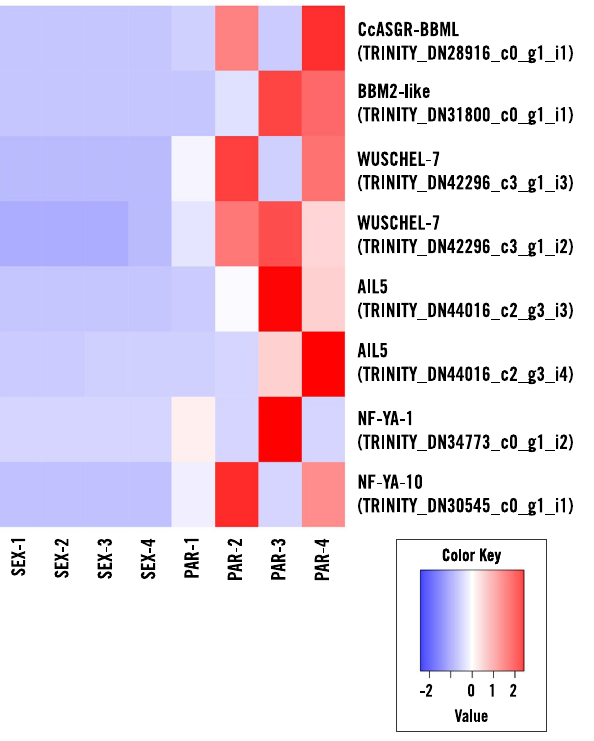
Figure 6. Heatmap of specific transcription factor TPM values. This heatmap represents embryogenic associated transcription factor transcripts with rows representing each transcript (labeled by the gene name and Trinity ID) and relative expression (low in blue and high in